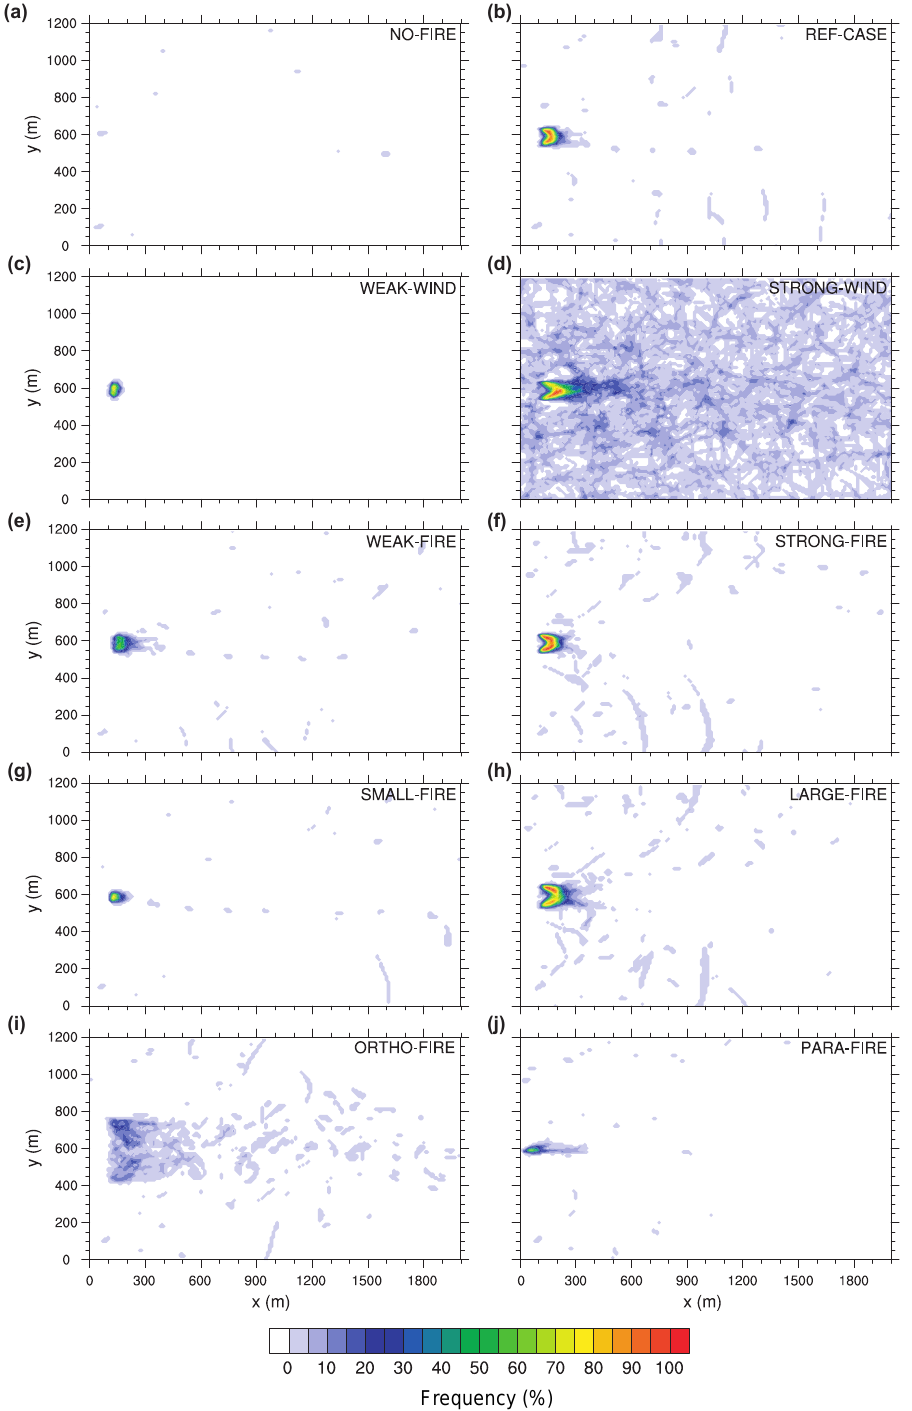
Figure 11. Spatial distribution of areas where both the horizontal threshold velocity v tres = 6ms − 1 (see Fig. 9) and a vertical wind velocity w 4 greater than 0.27ms − 1 (see Fig. 10) are exceeded at the same time. Shown is the frequency of occurrence of such events per grid